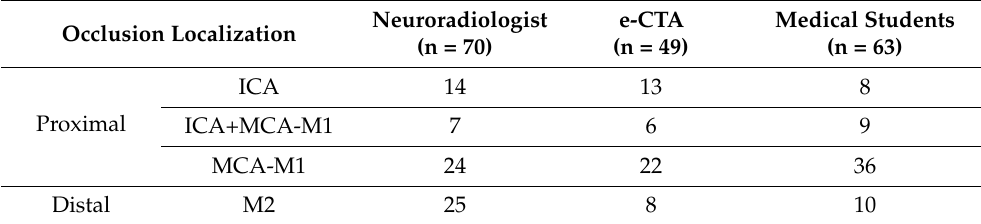
Table 1. Distribution of LVOs detected by neuroradiologist, e-CTA and medical students. Occlusion Localization